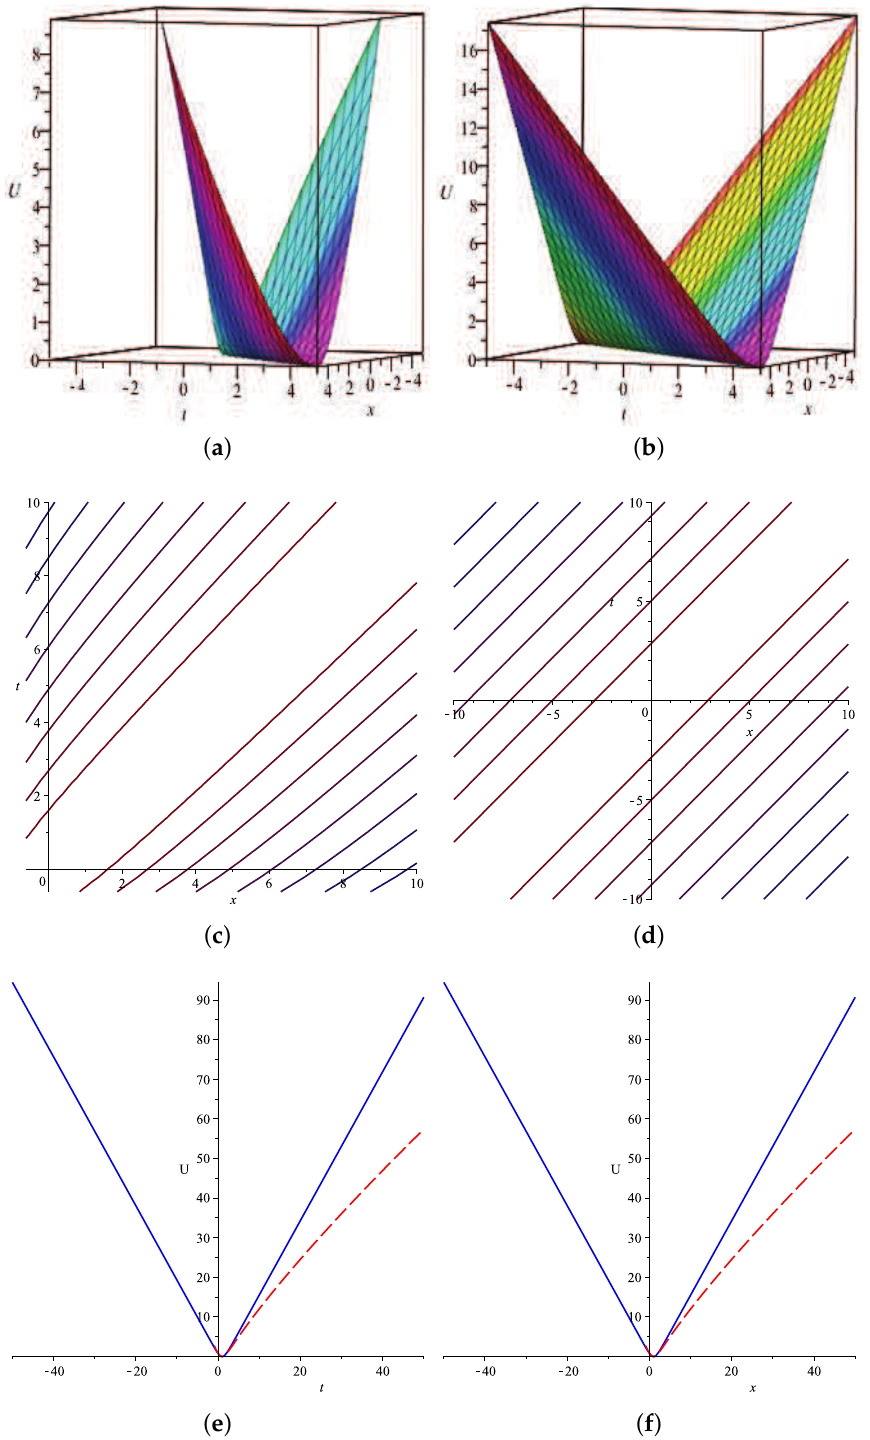
Figure 3. In ( a ), the graph of Equation (36) is given with β = 0.83 whereas in ( b ) graph of Equation (37) is given with β = 0.83 and α = 1. In ( c , d ), the 2D contours corresponding to the graphs ( a , b ) are given. ( e , f ) show 2D comparison of both solutions for x = 1 and t = 1,